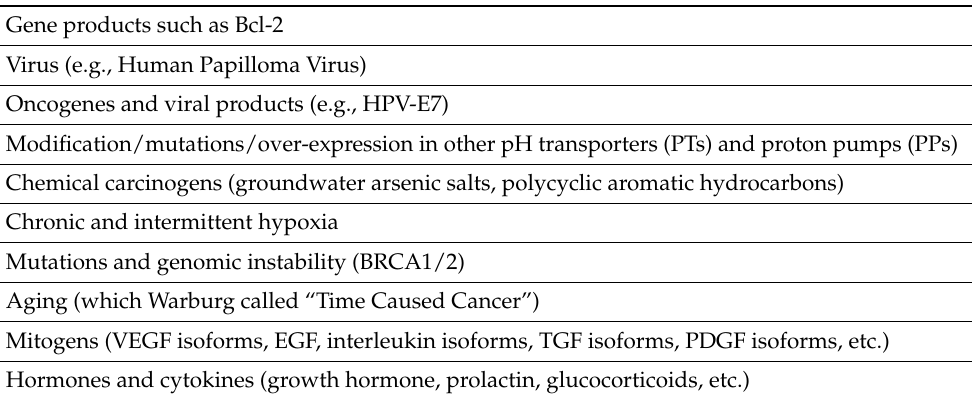
Table 2. Intermediary neoplastic drivers become carcinogenic through the final increase in cell pH and/or NHE1